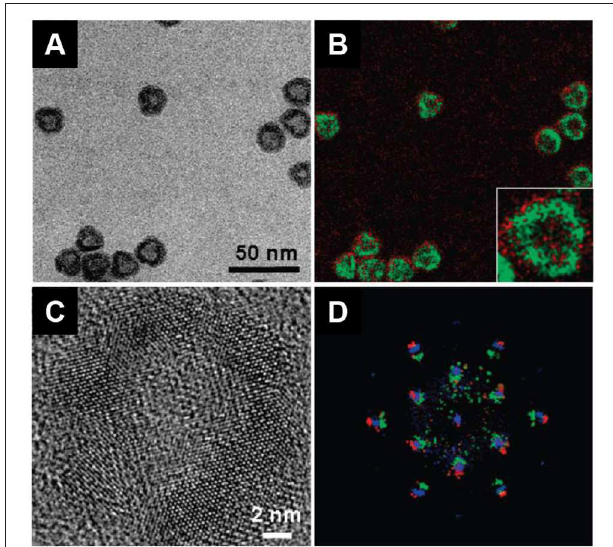
FIGURE 19 | TEM (A) , EFTEM (B) , and HRTEM (C) of annealed core-shell nanoparticles. EFTEM strongly suggest the formation of a ZnO 1 − x S x nanoalloy. (D) FFT image of (C) overlaid on FFT image of the precursor ZnO@ZnS core-shell nanoparticles (red: ZnO; green: ZnS; blue: annealed nanoparticles). These images support the heteroepitaxial formation of the ZnS shell and ZnO 1 − x S x when thermally annealed. Adapted with permission from Park et al. (2009), copyright (2006) American Chemical